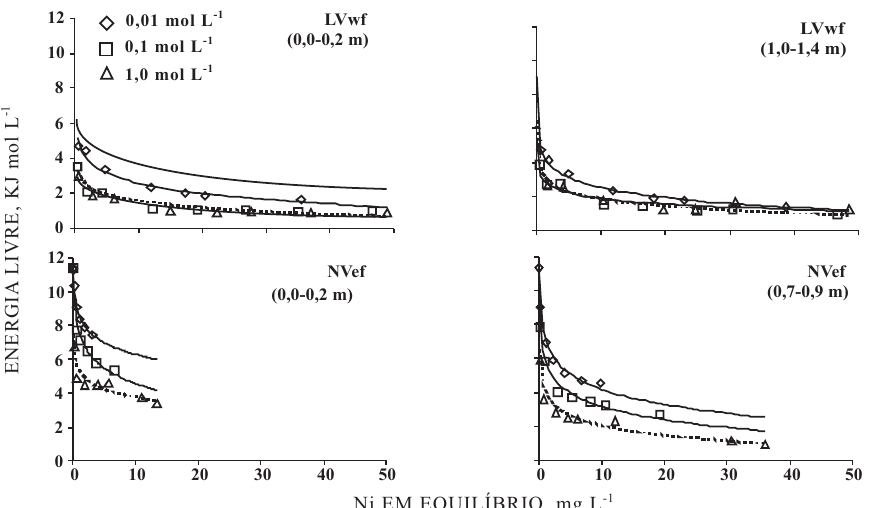
Figura 1. Energia livre da reação de adsorção de Ni para Latossolo Vermelho acriférrico (LVwf) e Nitossolo Vermelho eutroférrico (NVef), coletados em superfície e profundidade, utilizando NaCl nas forças iônicas 0,01; 0,1; e 1,0 mol L -1